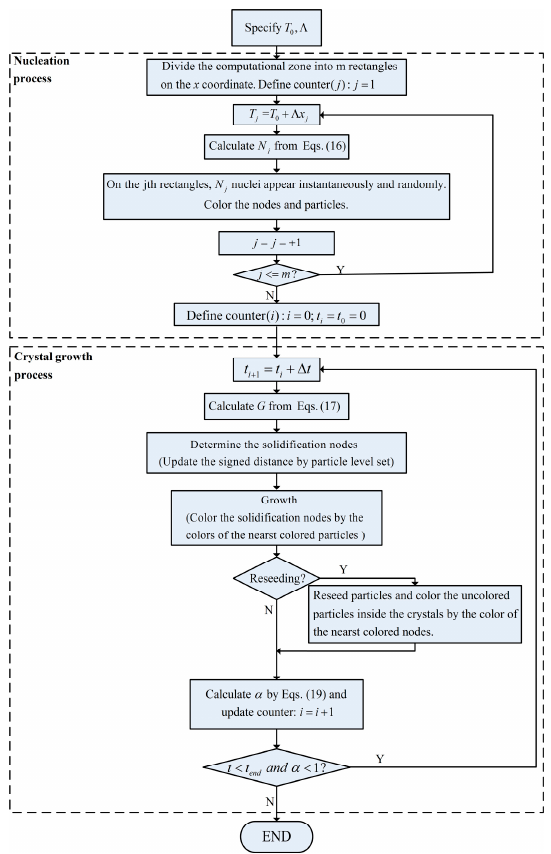
Figure 5. Algorithm for polymer crystallization in the uniaxial linear temperature field by the particle level set method.